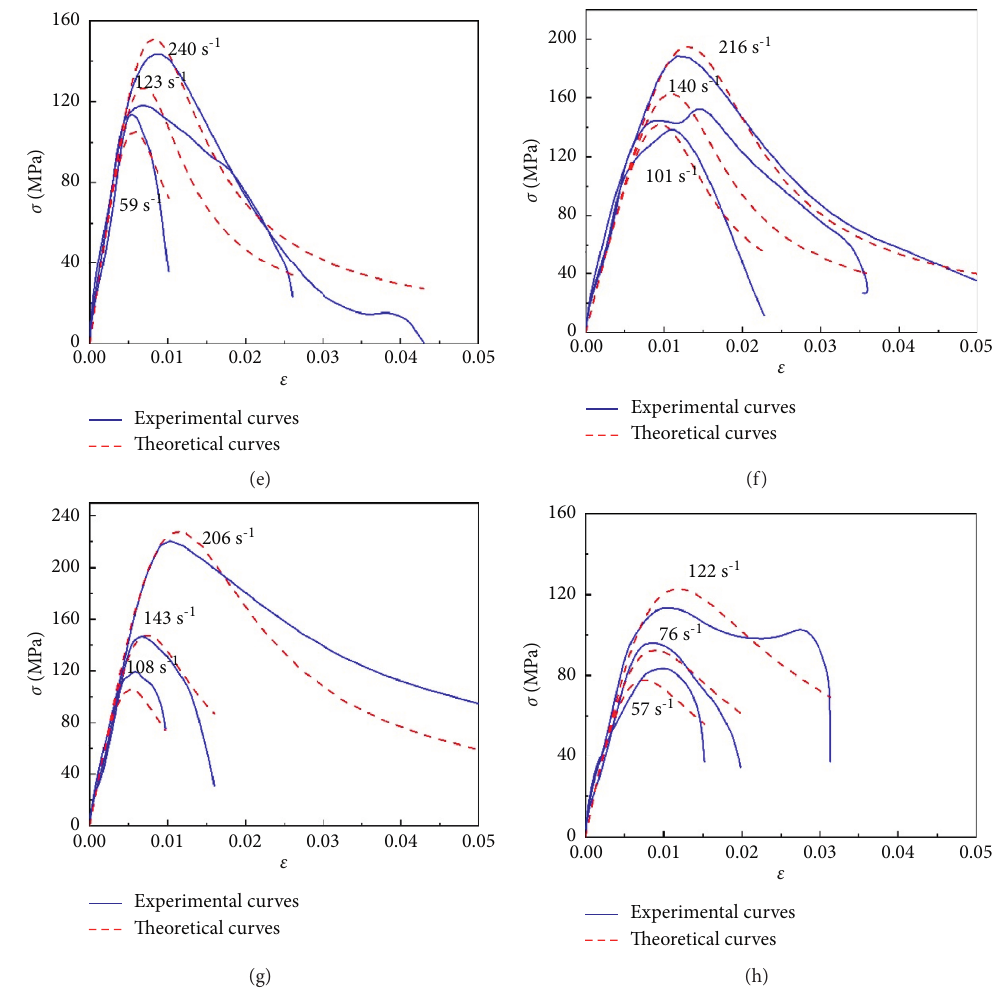
Figure 10: Comparison between experimental and theoretical stress-strain curves: (a) MC-F0.5; (b) MC-F1.0; (c) MC-F1.5; (d) MC-F2.0; (e) HC-F0.5; (f) HC-F1.0; (g) HC-F1.5; (h)